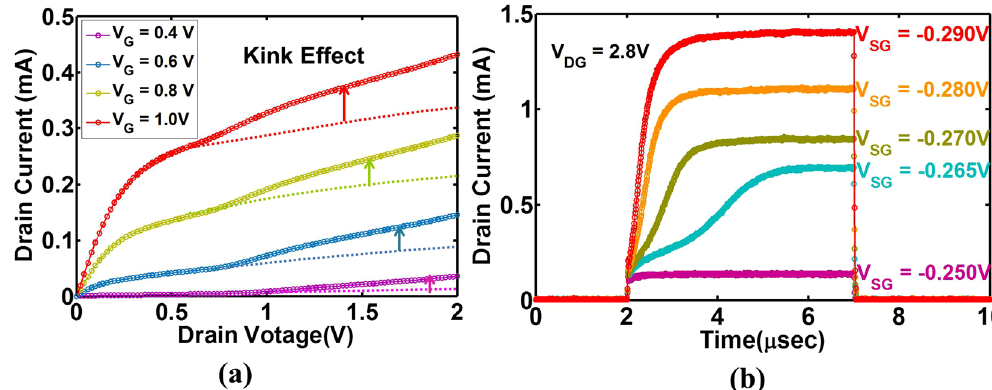
Figure 4. ( a ) I D − V D curve for different V G shows “kink effect” as a signature of impact ionization induced floating body effect, ( b ) Transient measurement showing Leaky, Integrate functions for different input bias.